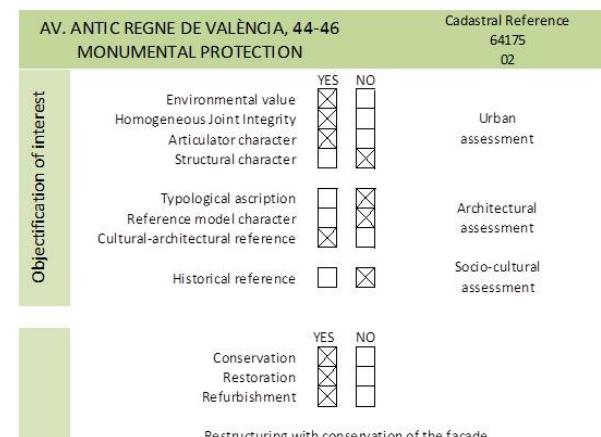
Figure 2. Façade of CIPFP Blasco Ibáñez.